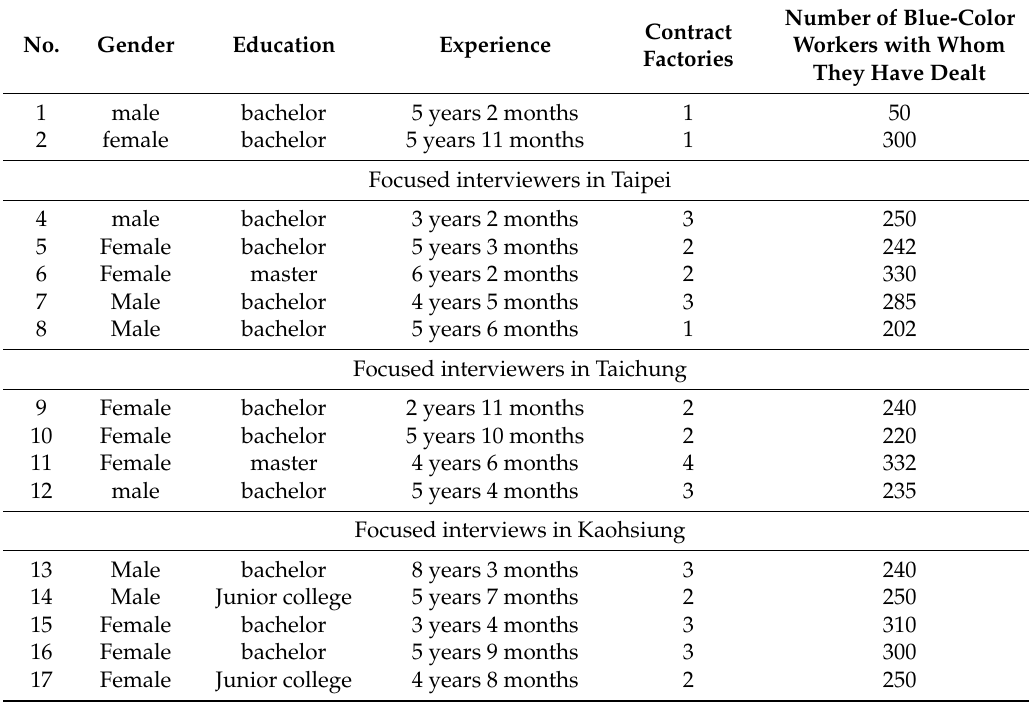
Table 1. Backgrounds of